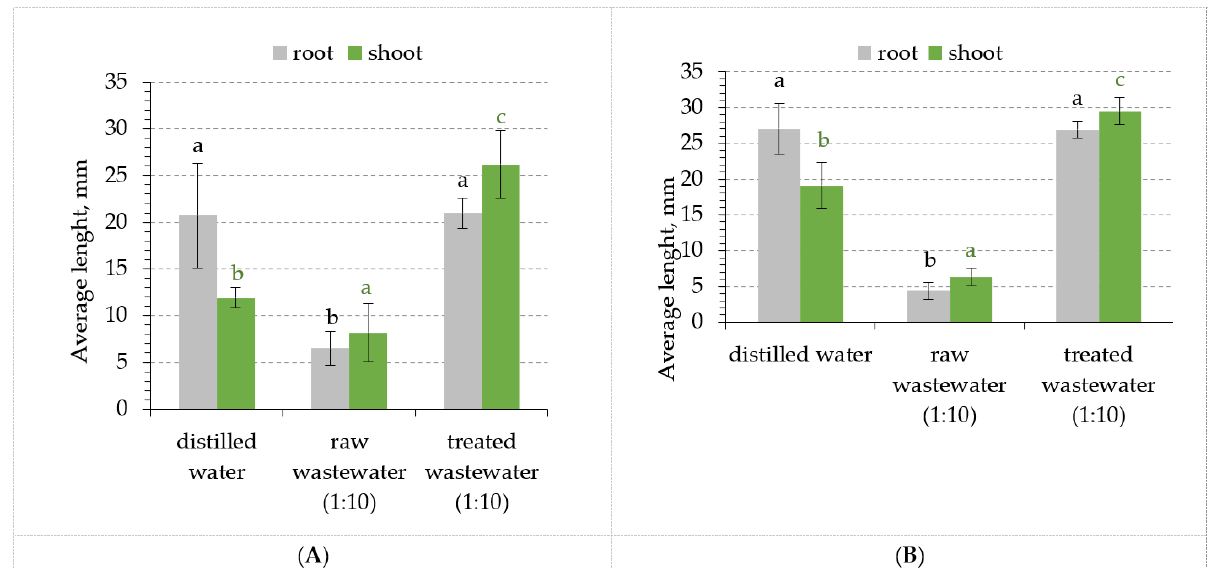
Figure 8. The lengths of roots and shoots of tested plants for distilled water (blank sample), raw and treated wastewater (1:10); ( A ) S. alba , ( B ) L. sativum L. The combinations of different letters indicate statistically significant differences at p < 0.05 (one-way ANOVA, post hoc Tukey HSD test).